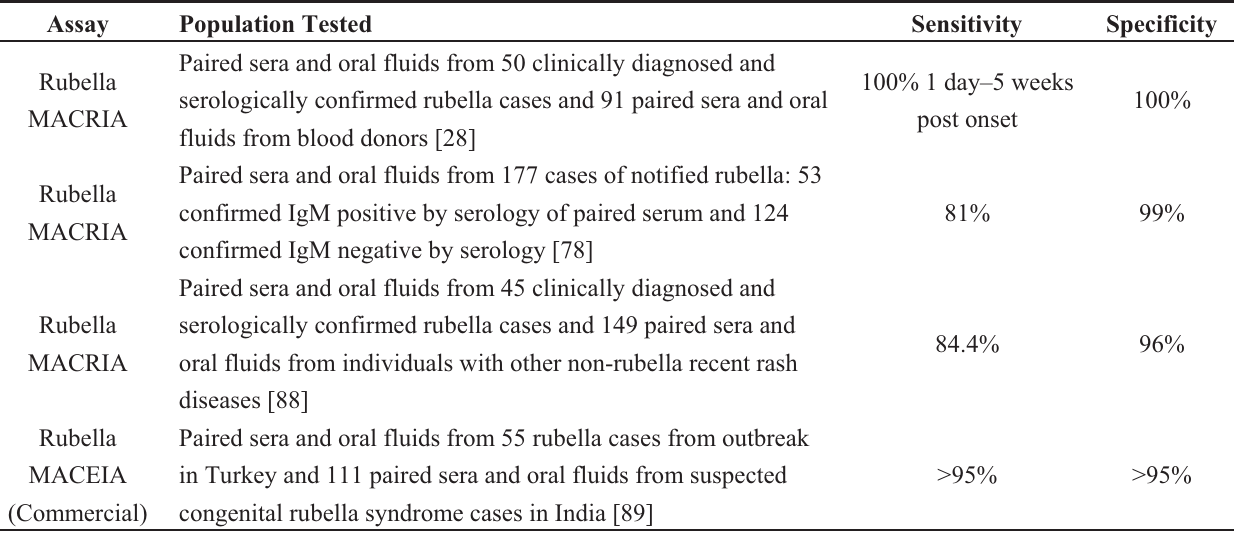
Table 2. Reported performance of rubella class IgM capture radioimmunoassays (MACRIA) and enzyme immunoassays